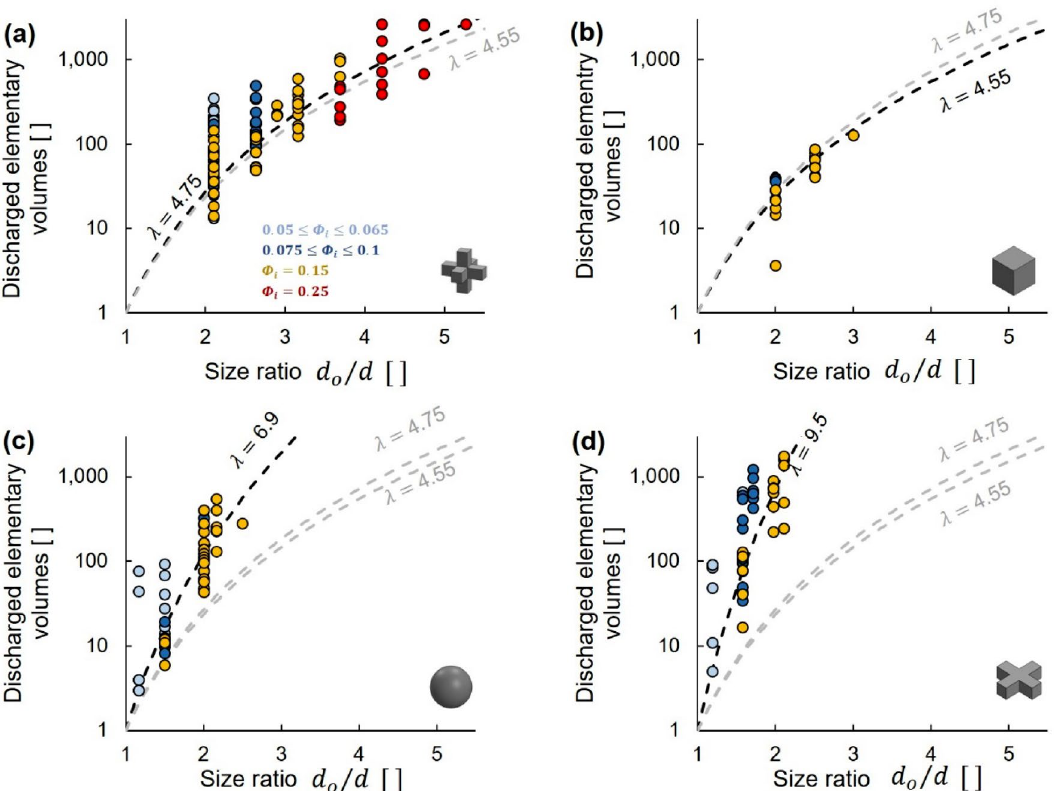
Figure 5. Particle-laden fluid flow: discharged elementary volumes before clogging as a function of orifice-to- particle size ratio d o / d . Granular shapes: ( a ) 3D crosses, ( b ) cubes, ( c ) spheres and ( d ) 2D crosses. Datapoints: 280 independent experimental realizations, colored by initial suspension solidity Φ i . Lines: power function (Eq. 5). The λ -exponent is a shape-related fitting parameter. Light gray lines added for relative reference among